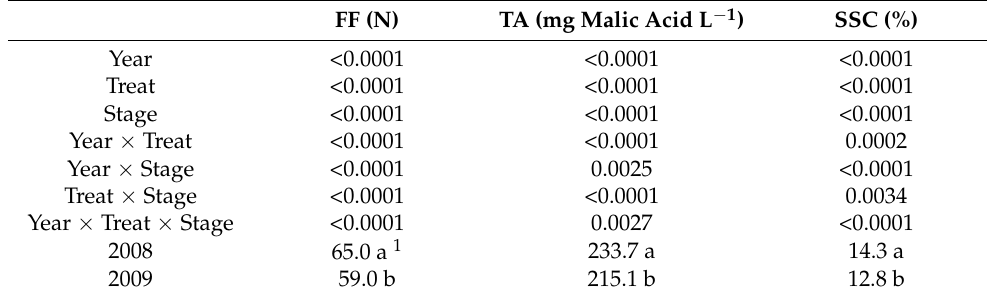
Table 4. Combined statistical significance of the effects of the irrigations on the changes of the compositional attributes of Ambrosia TM apples in the years 2018 and